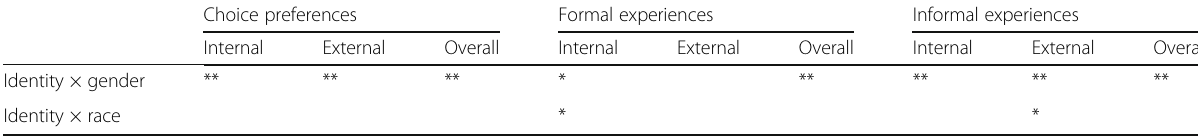
Table 7 Statistical significance of interactions between identity and gender or race in predicting optionally preferred and actual science experiences across science identity